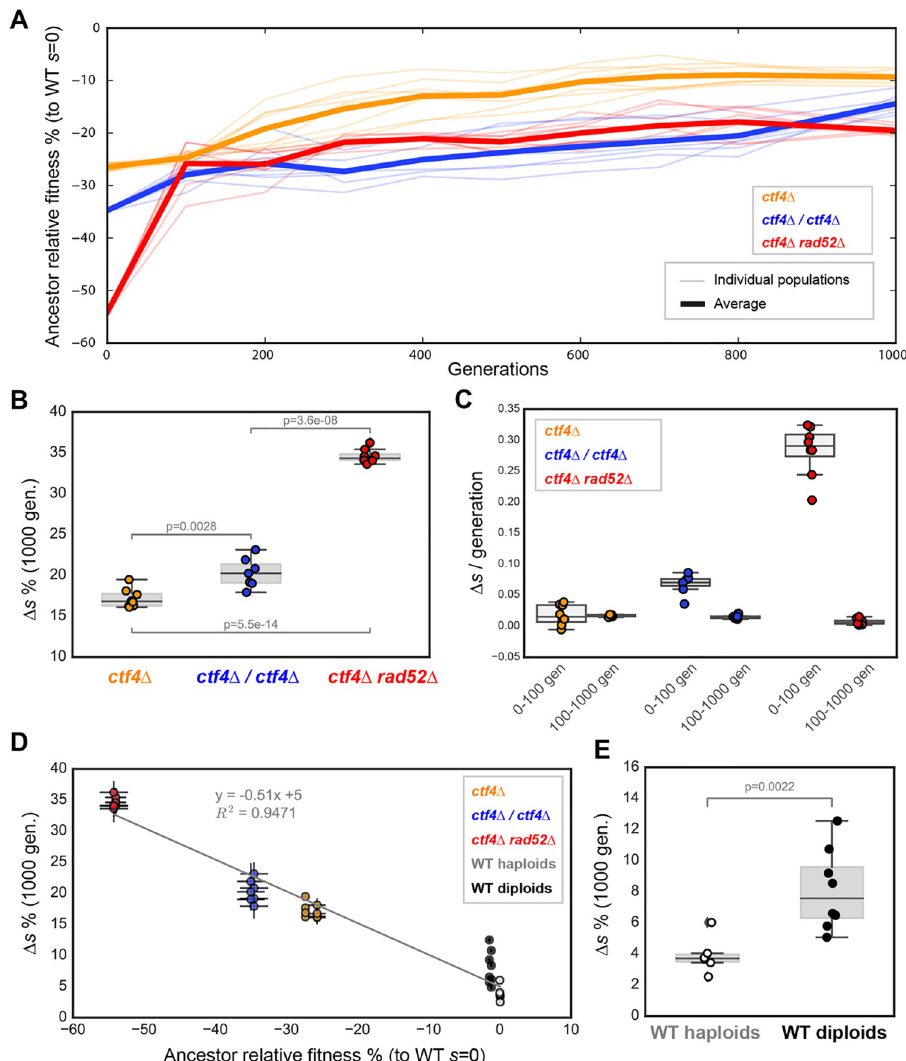
Fig 2. Fitness increase over 1000 generations. (A) Fitness change over the course of evolution for strains with ctf4 Δ - induced replication stress. Average trajectories for populations with different genomic features are shown as thick lines. Thin traces represent individual populations’ trajectories. (B) Absolute fitness increase over 1000 generations for the evolved populations. Δ s is the difference between the fitness of the evolved populations and the fitness of their ancestors, with both fitnesses measured relative to that of cells that contain Ctf4 ( CTF4 ) and have the same ploidy. (C) . Adaptation rates (measured as Δ s /generation) during the early phase of evolution (0 to 100 generations) and the rest of the experiment (100 to 1000 generations). (D) Shows the correlation between the fitness increase during evolution ( Δ s ) and the fitness defect of the ancestors relative to cells of the same architecture containing Ctf4 (the ancestor relative fitness). (E) Absolute fitness increase over 1000 generations for control strains that contained wild-type CTF4 . Fitness data of haploid strains (orange and white) is from [17]. Error bars represent standard deviations. Grey line represents linear regression between the datapoints. The P-values reported in figures are the result of t-tests assuming unequal variances (Welch’s test). The data shown here are reported in or derived from S1 Data. genome) had similar but statistically different mutation frequencies (p = 4x10 -6 , Welch’s test, S5A Fig) but recombination-deficient clones carried many more mutations, both in total (50/ haploid genome, S5A Fig) and as synonymous mutations (7/haploid genome, S5B Fig). Our results agree with the reported increase in spontaneous mutagenesis in rad52 Δ cells [71–73].